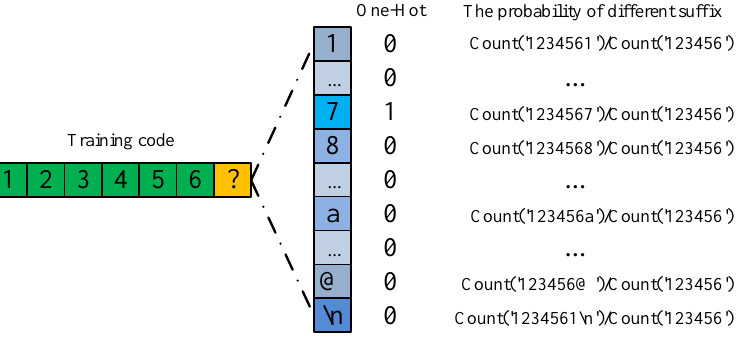
Figure 3. One-Hot Encoding and the probability of different password